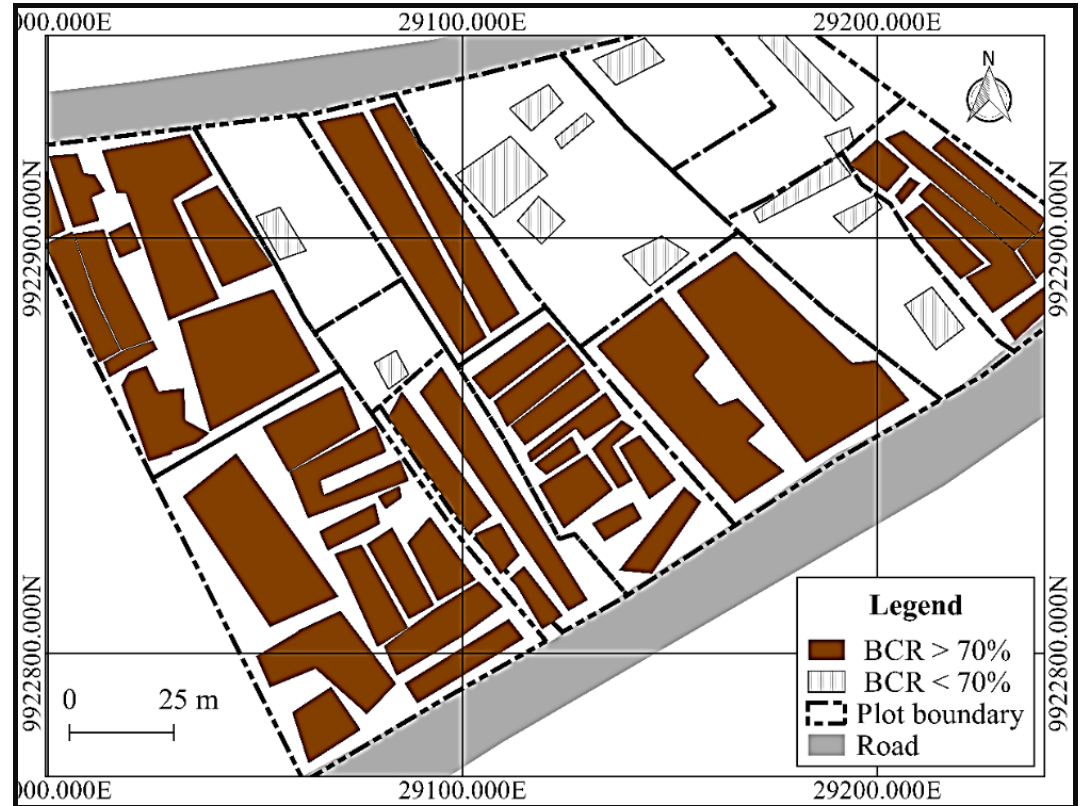
Fig. 6: Implication of high BCR on car parking space